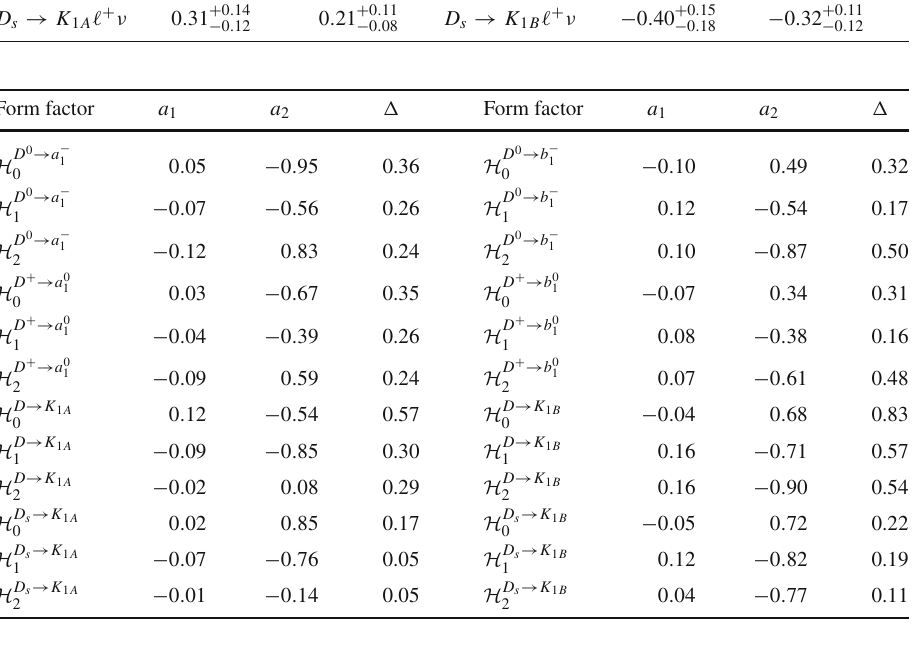
( b 0 ) (cid:2) + ν , 1 1